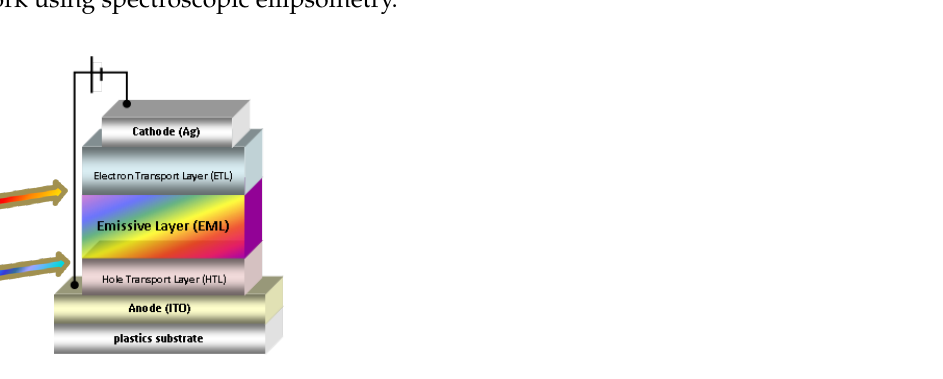
Figure 1. The multilayer OLED structure, with solution-processed HTL, EML, and ETL layers.